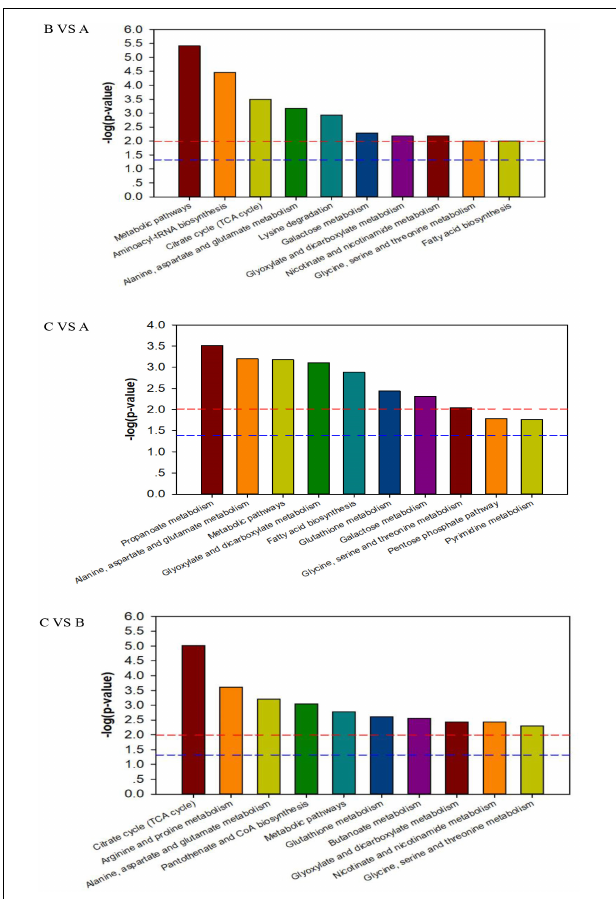
FIGURE 6 | The KEGG pathway enrichment analysis of differential metabolites between Mycelia B samples versus Mycelia A samples (B vs. A), Mycelia C samples versus Mycelia A samples (C vs. A), and Mycelia C samples versus Mycelia B samples (C vs. B). Each comparison mycelia only shows top 10 enrichments pathways of differential metabolites. P-value was calculated using Fisher’s exact